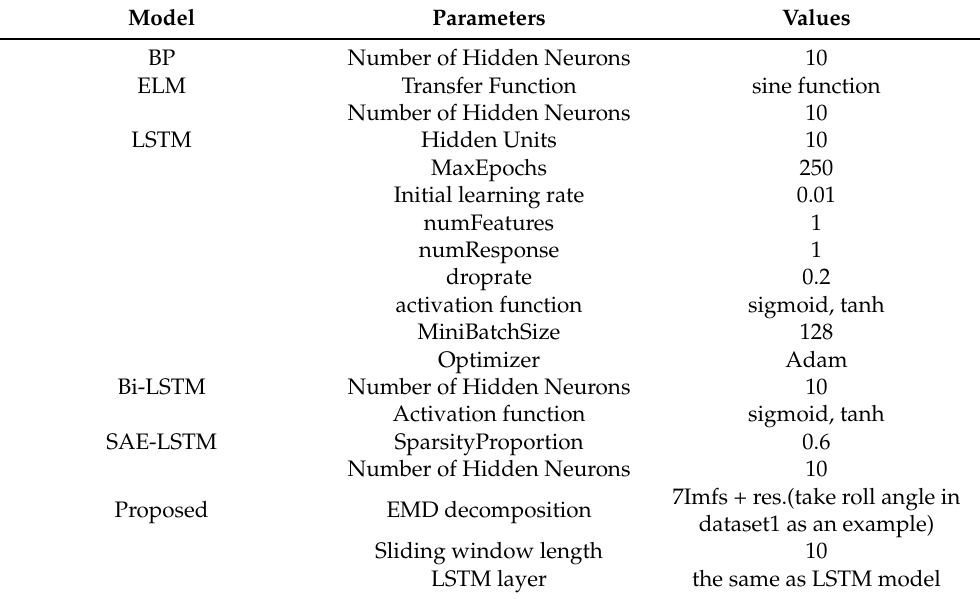
Table 3. Settings of different model